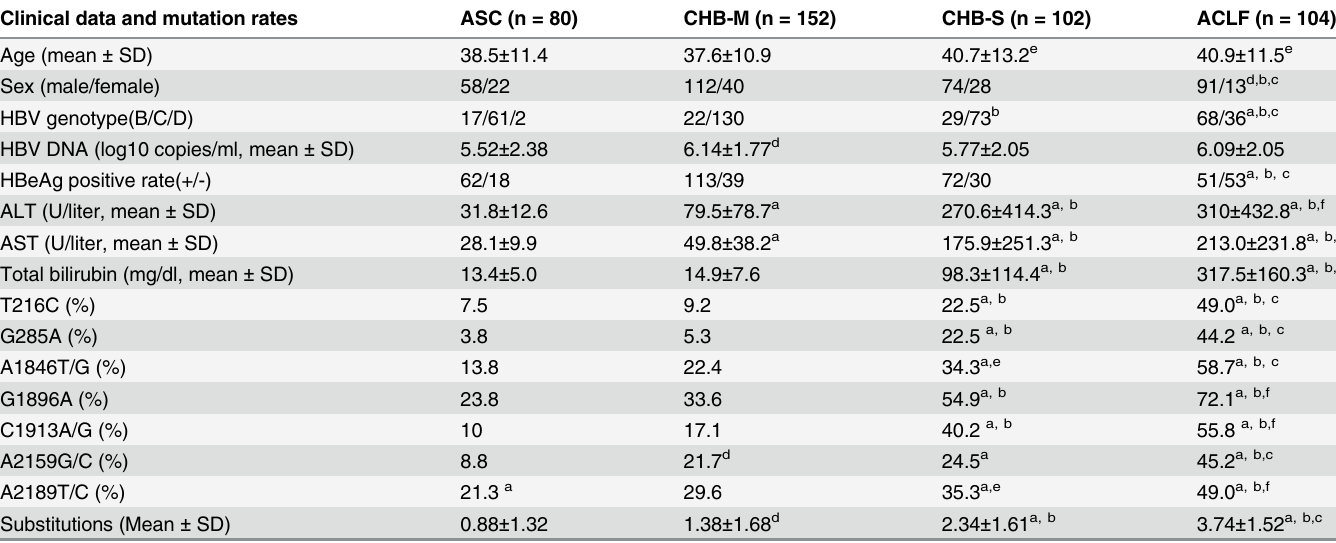
Table 3. The clinical data and HBV mutation profiles in 438 subjects. Clinical data and mutation